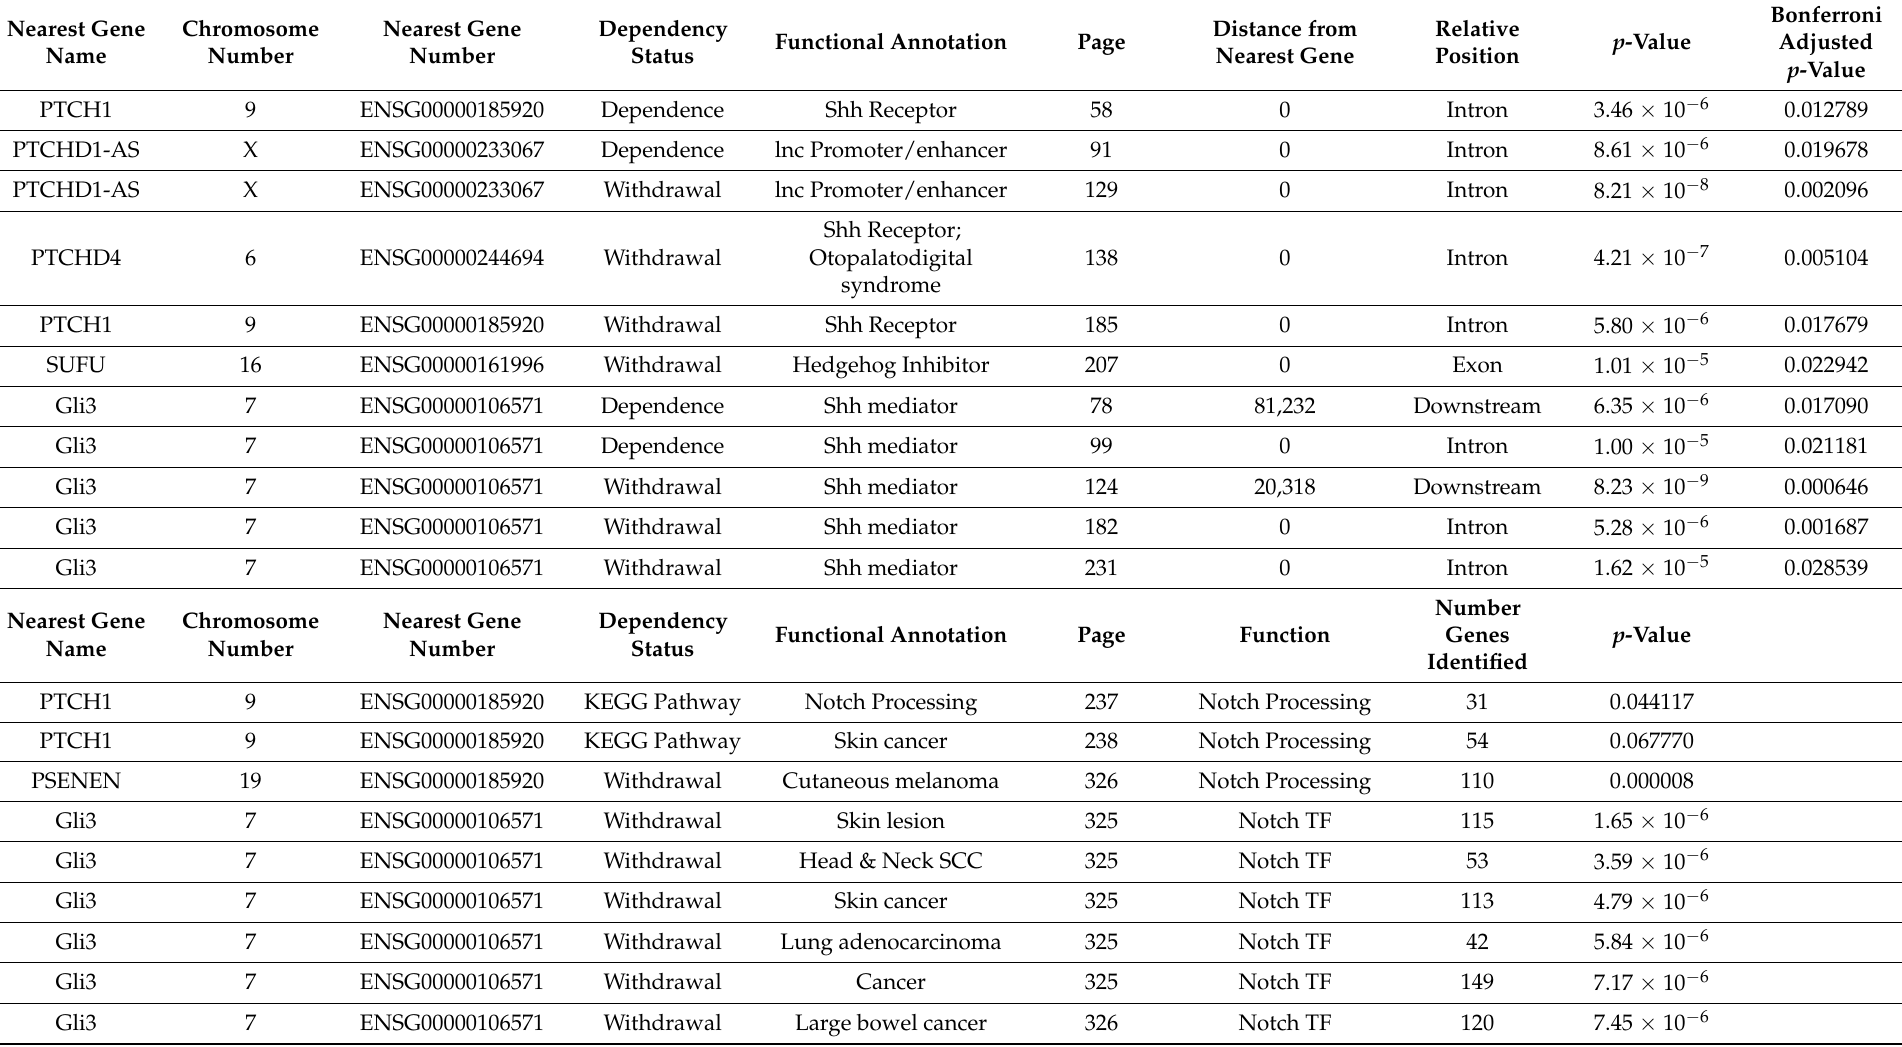
Table 18. EWAS Hits from Schrott Dataset for Significantly Differentially Methylated Regions for. Sonic Hedgehog